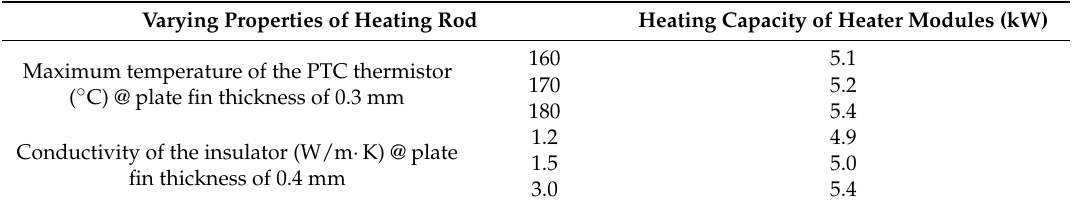
Table 2. Experimental results of the heater module performance for varying properties of heating rod.